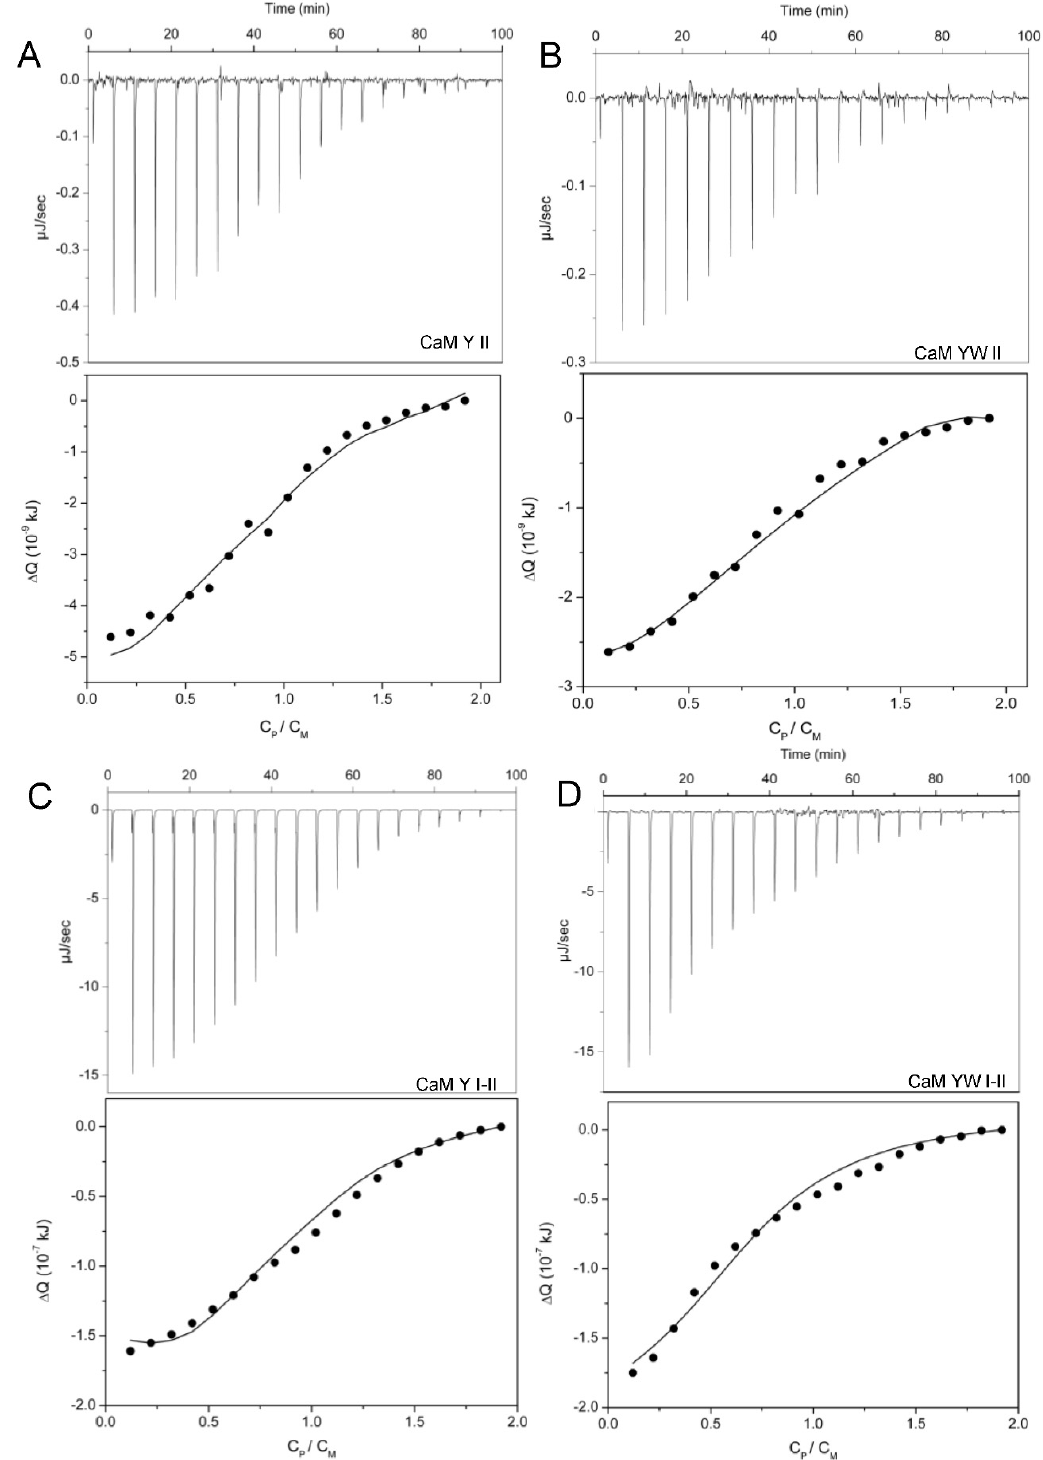
Figure 3. ITC raw data and binding isotherm for UO 22+ interaction with the one-site peptides ( A ) CaM Y II and ( B ) CaM YW II; C P = 1.10 − 3 M (syringe), C I = 2.10 − 4 M and C M = 1.10 − 4 M (cell) and with the non-phosphorylated two-site peptides ( C ) CaM Y I-II and ( D ) CaM YW I-II; C P = 2.10 − 3 M (syringe), C I = 4.10 − 4 M and C M =2.10 − 4 M (cell). pH = 6, T = 298 K. Experimental data (dots) and adjustment (black solid line), according to Equation (8) for the one-site peptides and Equation (13) for the two-site peptides. Analogue binding isotherms are reported in Figure SI-3 for CaM1 Y II and CaM1 YW II and in SI-6 for CaM1 Y I-II and CaM1 YW I-II.